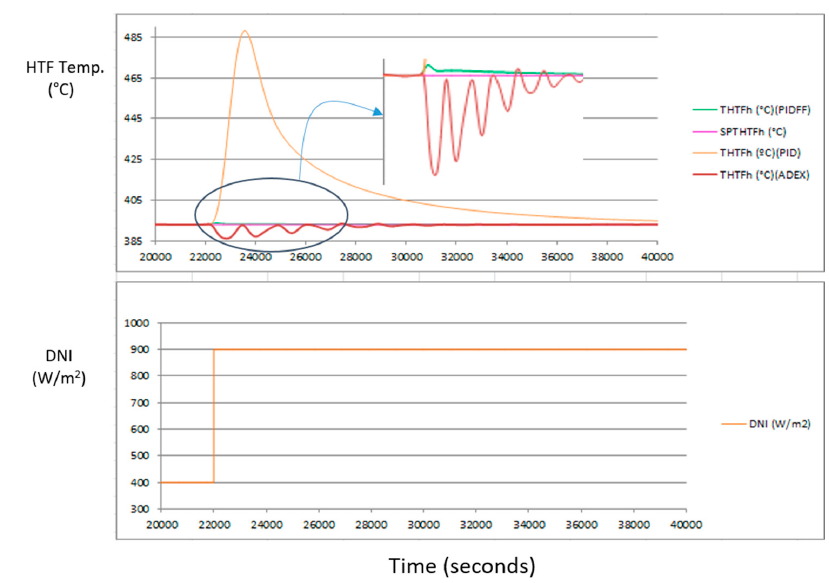
Figure 7. Heat transfer fluid temperature response to a sharp step in the DNI for different algorithms. The zoomed area shows, in detail, the overshoot and oscillations of the different regulators. Table 2. Comparison of the algorithms.